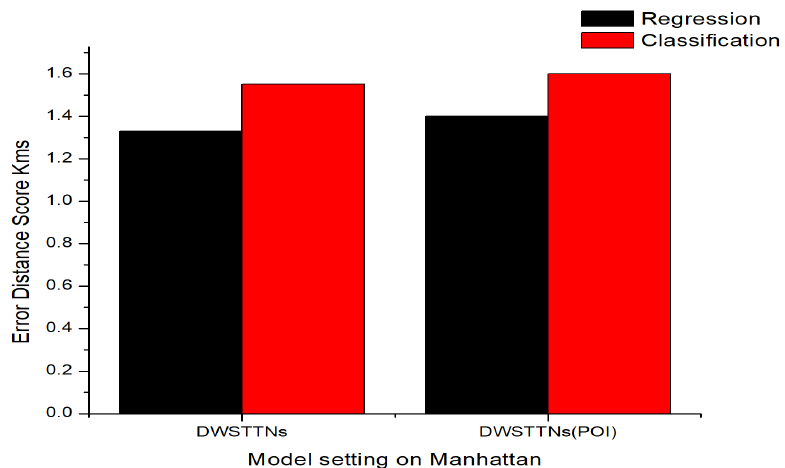
Figure 10. The Regression and classification performance on Manhattan